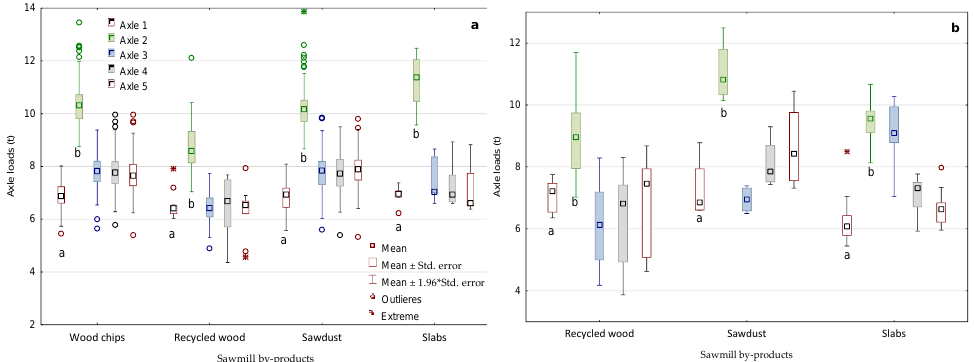
Figure 6. Distribution of the axle loads in the transport sets, according to: ( a ) transport set (TT(6)- six-axle set), ( b ) sawmill by-products assortment load. Groups with similar lower-case letters (a, b, c, d, under the box plots) indicate significant similarities, according to a Mann – Whitney test, Krus- kal – Wallis test or Dunn ’ s multi-sample rank mean comparison test.